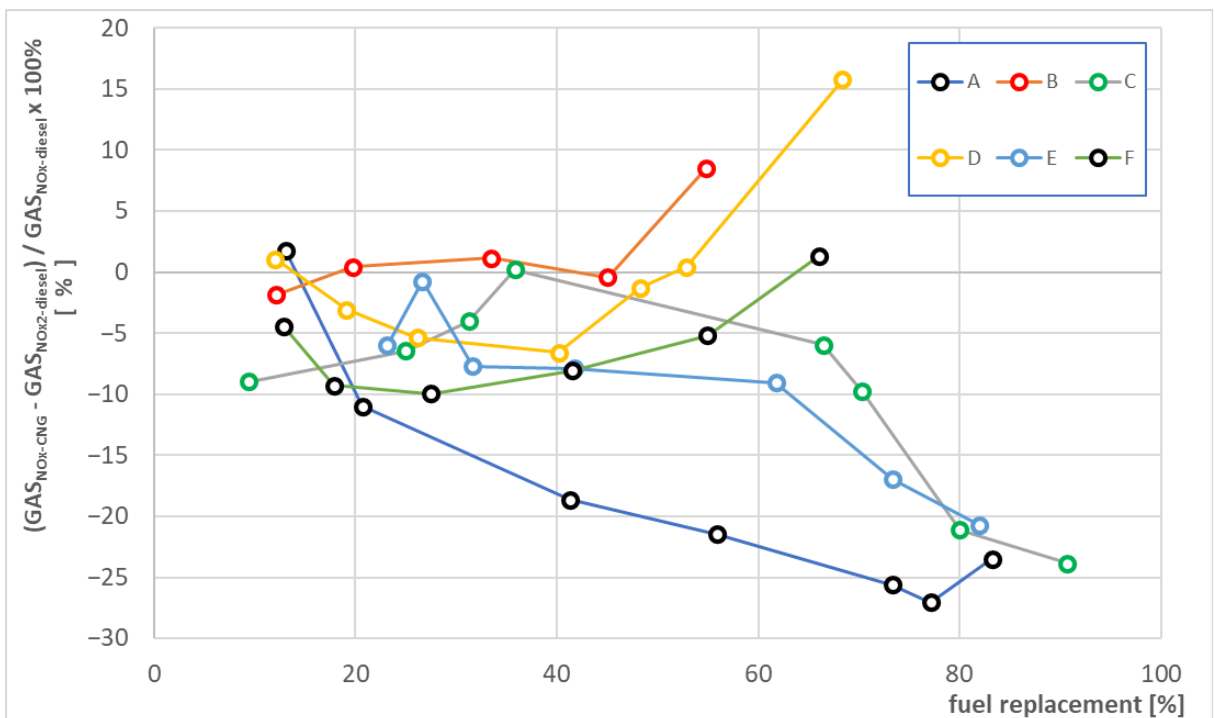
Figure 10. Curves from A to F showing the changes in the emission of nitrogen oxides as the comparison of exhaust gas temperature noted only in single fuel (diesel) working mode for individual engine operating points, where the rotation speed, power and torque were constant, as a dual-fuel mode (where engine uses CNG and diesel fuel) replacement function.